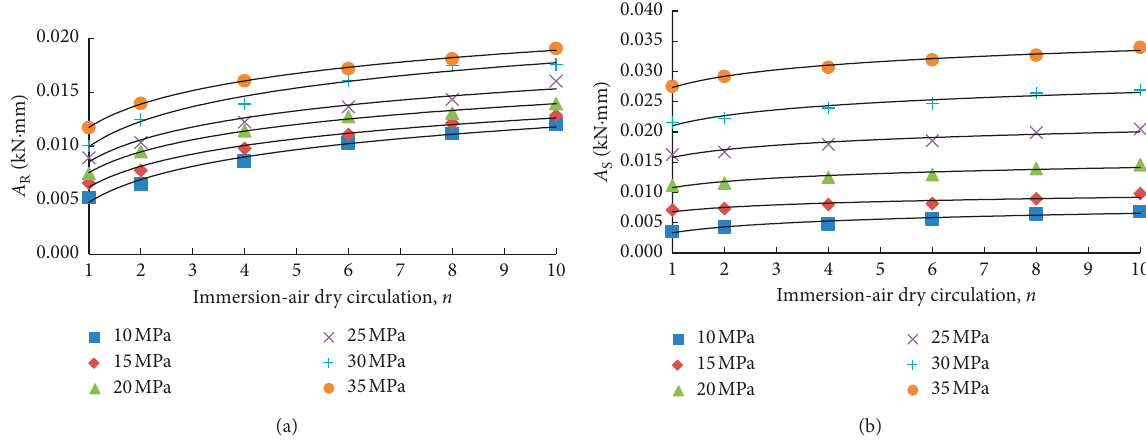
Figure 8: The variation curves of A